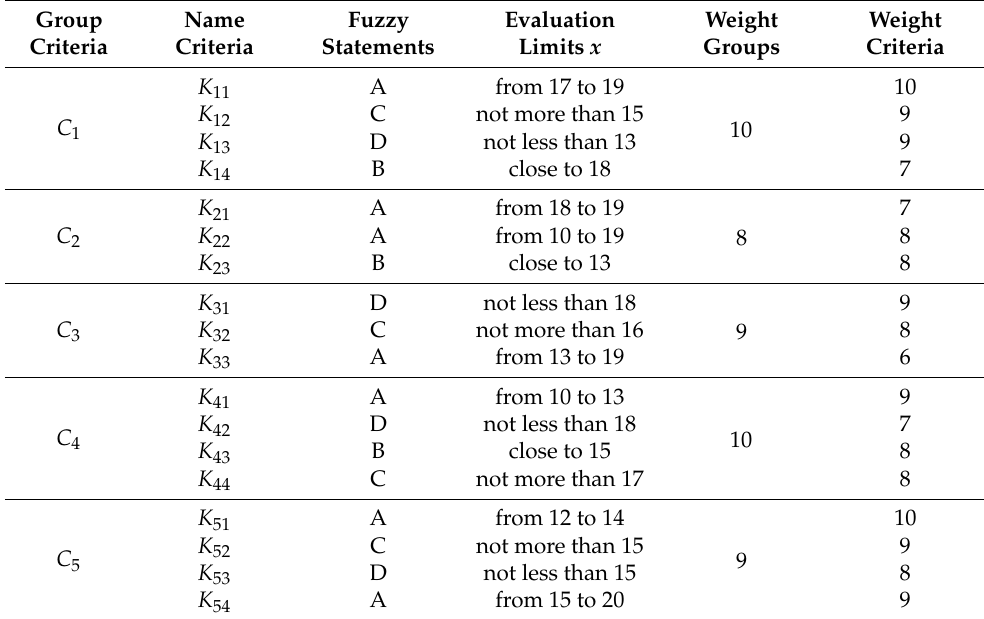
Table 1. Input data on expert evaluation according to K P